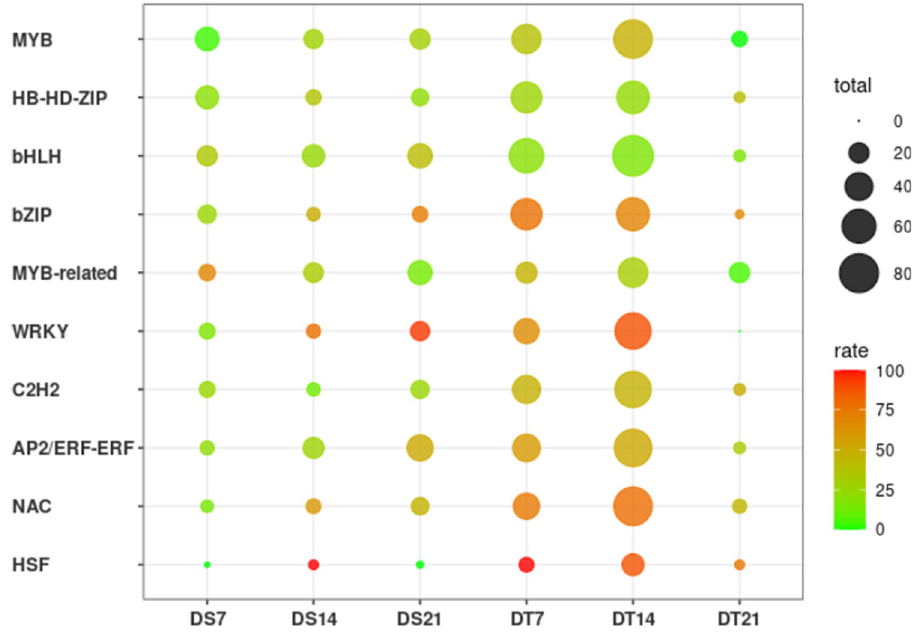
Fig 6. Ten transcription factor families with the largest number of genes. The size of the circle represents the total number of transcription factors, and color represents the proportion of up/down-regulated genes in total genes, The redder the color, the more genes are up-regulated, and the greener the more genes are